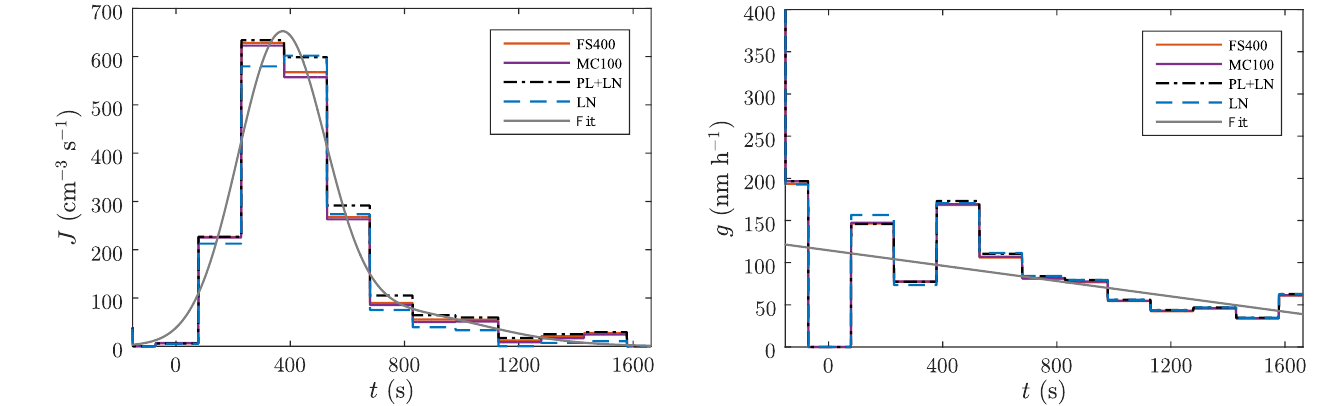
Figure 7. Time series for the condensational growth rates in the chamber event that produce the measured concentrations, N , S , and M , the most accurately compared to the measured ones, using dif- ferent models. The fit denotes a linear function fitted to the values from the FS400